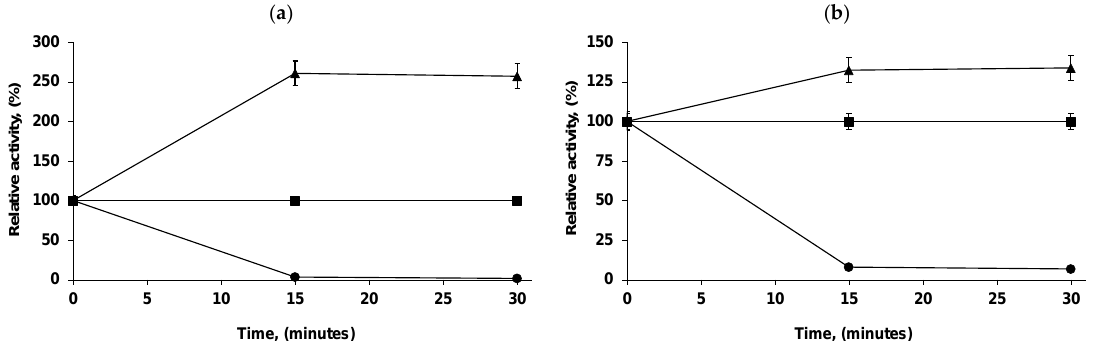
Figure 2. Immobilization courses of TLL on octyl agarose beads using enzyme loadings of ( a ) 0.2 mg / g or ( b ) 1 mg / g. Other specifications are described in the Methods section. Solid squares: reference; filled triangles: suspension; filled circles: supernatant.